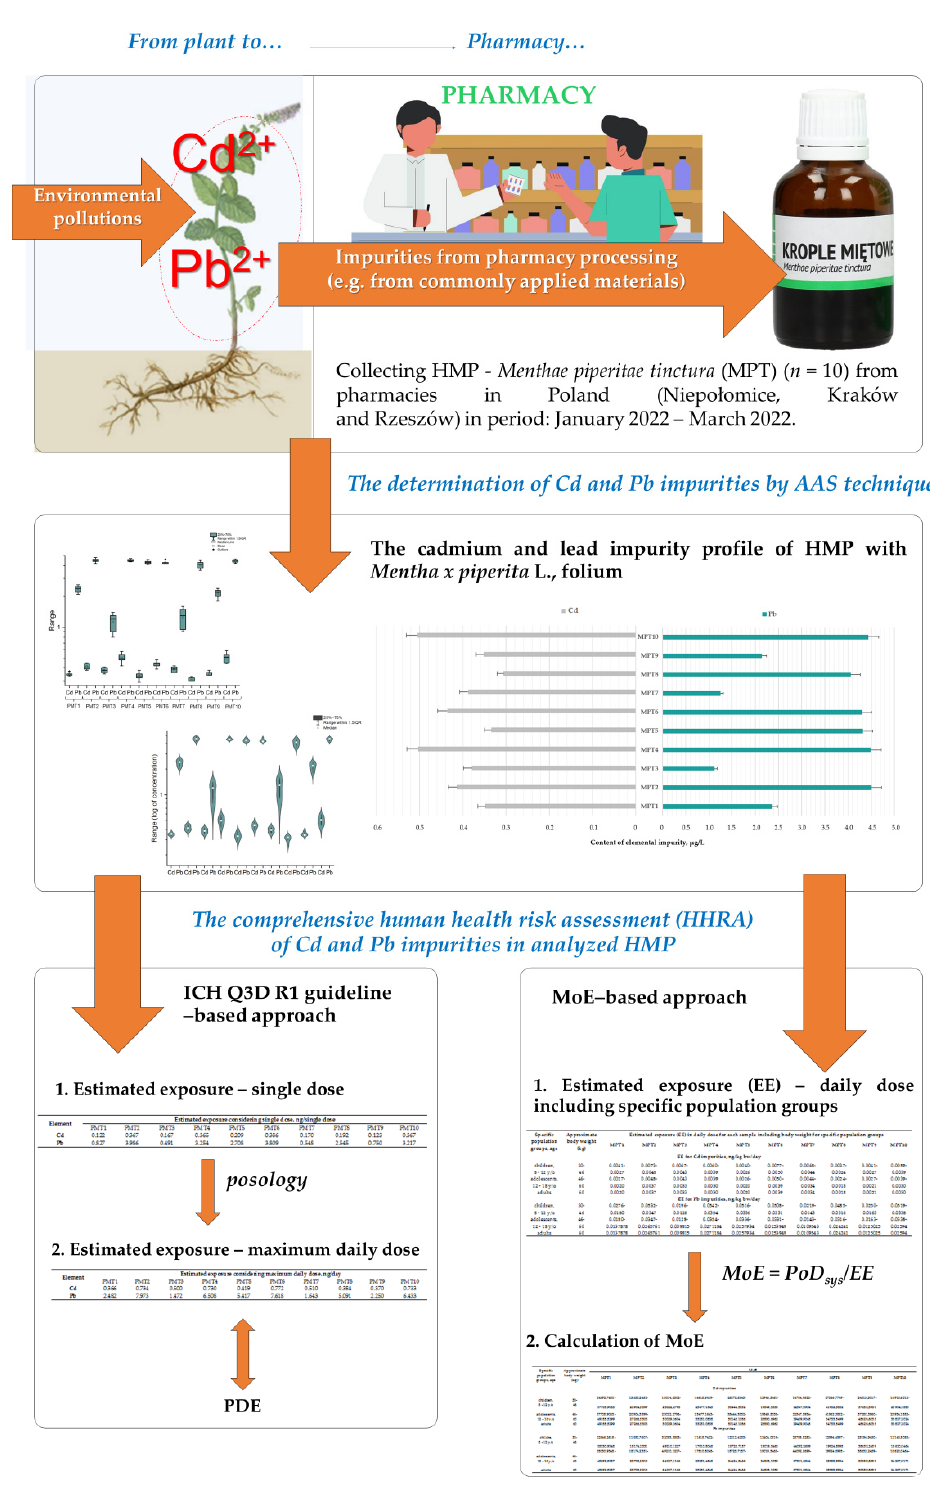
Figure 1. The graphic summary of the applied strategies in comprehensive human health risk assessment (HHRA) of Cd and Pb impurities in HMP with Mentha × piperita L., folium available in Polish pharmacies.